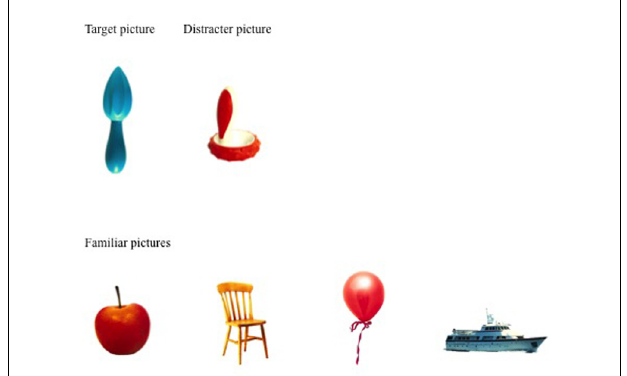
FIGURE 1 | Example stimuli